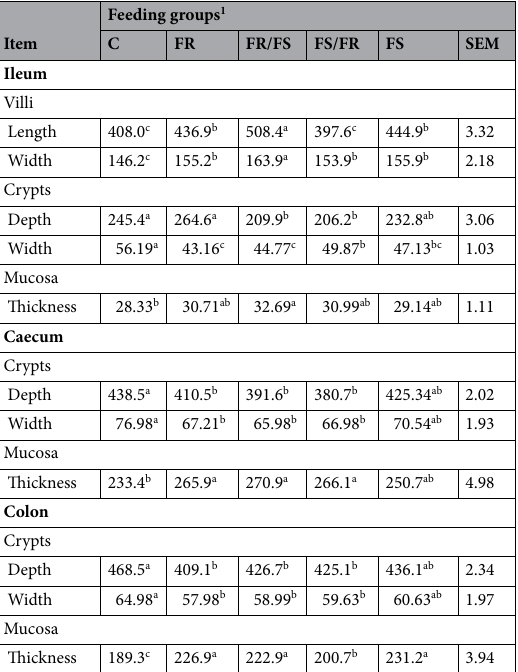
Table 5. Histological appearance and intestinal morphology in piglets (µm). a,b,c Values in rows marked with different letters differ significantly at p ≤ 0.05. 1 Feeding groups: C—control; FR—group receiving a diet with 8% FRSM; FR/FS—group receiving a diet with 6% FRSM and 2% FSBM; FS/FR—group receiving a diet with 6% FSBM and 2% FRSM; FS—group receiving a diet with 8%